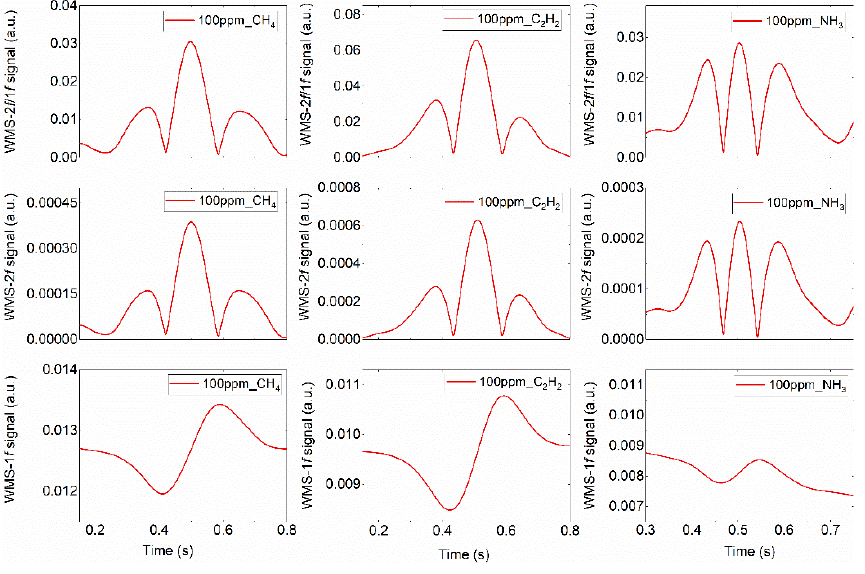
Figure 5. Representative WMS-2 f /1 f , WMS-2 f and WMS-1 f signals for 100 ppm CH 4 , C 2 H 2 and NH 3 concentrations.